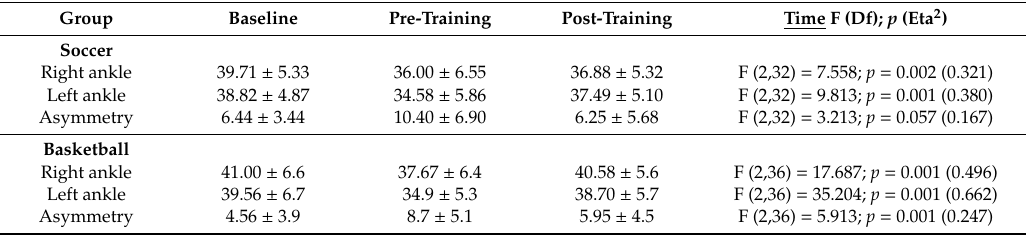
Table 2. One-way ANOVA for the ankle ROM and asymmetry variables.